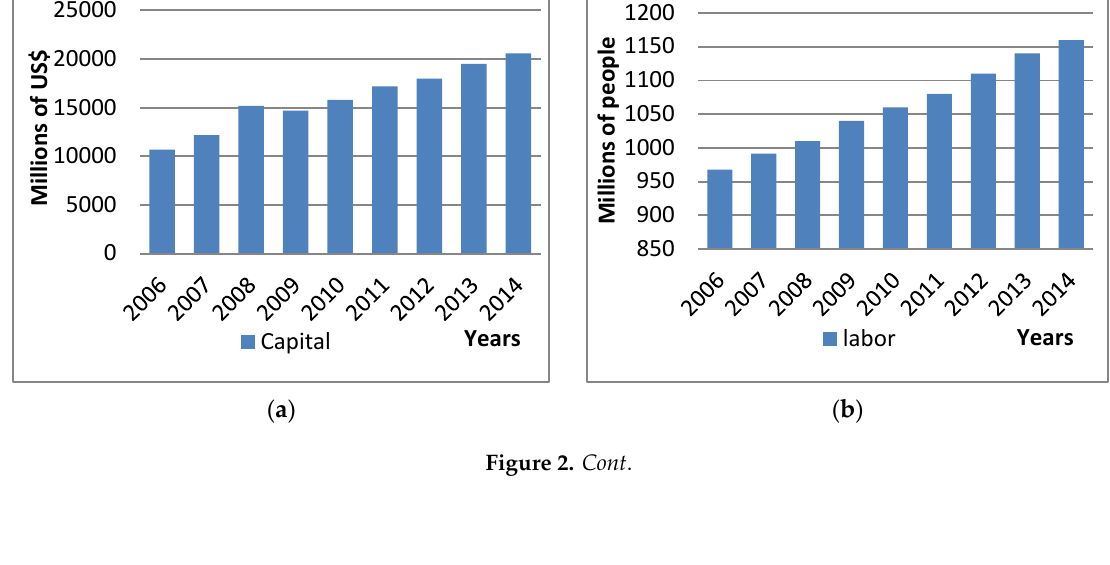
Figure 2. Mean statistical indexes of the understudy variables from 2006–2014: ( a ) capital; ( b ) labor; ( c ) energy; ( d ) CO 2 ; and ( e ) GDP. From Figure 2, the mean values of energy consumption have risen till 2011 when they drop slightly and continue to increase for the remaining years. Noticeable again is the average CO 2 emission values, that continue to increase for the entire sample period except a slight decrease in